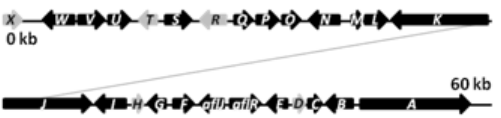
Figure 3. The sterigmatocystin gene cluster. The black arrows are predicted stc ORFs, while light grey arrows are genes with unassigned